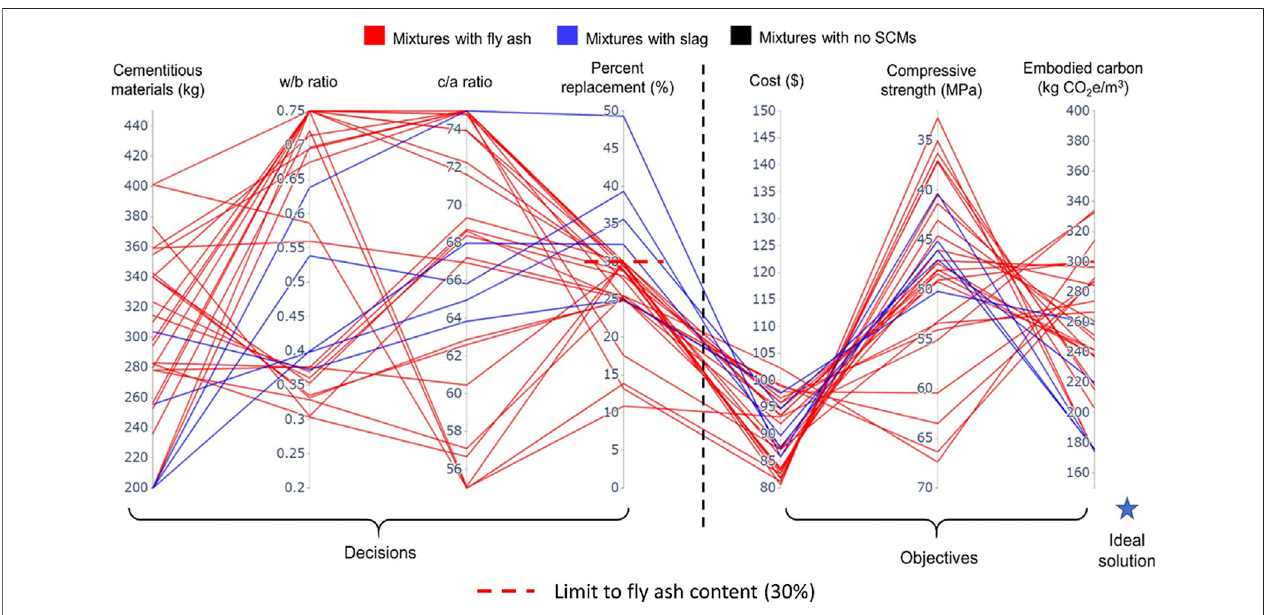
FIGURE 3 | Set of optimal mixture designs for Miami case